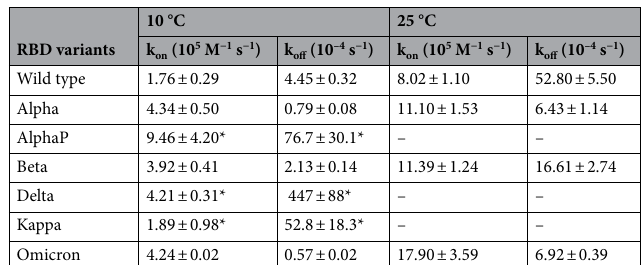
Table 2. Kinetic constants of the interactions between the RBD variants and ACE2 at 10 °C and 25 °C. *Indicates kinetic constants for which fits were judged imperfect.